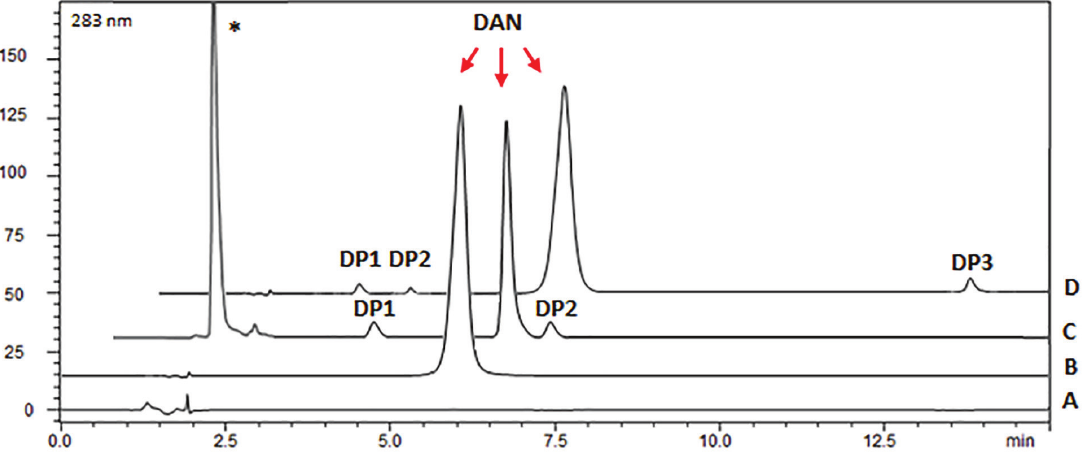
FIGURE 1 - Chromatograms obtained from DAN in injectable solution by LC: (A) placebo solution of excipients; (B) drug product DAN; (C) oxidative degradation (30% H peroxide